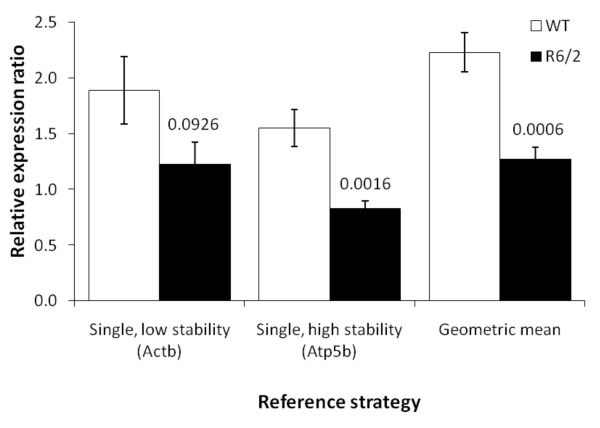
Comparison of normalisation strategy. Relative expression analyses using either a single reference gene with low stability between wild-type (WT, open bars) and R6/2 (filled bars) cortex such as Actb, a single reference gene with high stability between the two genotypes such as calnexin or the geometric mean of three highly stable reference genes. P-values above the R6/2 bars show that while a single, stably expressed gene (p = 0.0016) is a better calibrator than a gene with low expression stability between the two genotypes (p = 0.0926), calculating the geometric mean of three stably expressed genes is a far superior normalisation strategy (p = 0.0006). Error bars are S.E.M (n = 6).